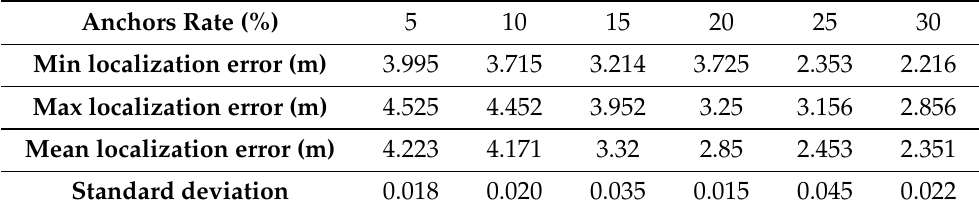
Table 1. Localization error as function of anchor rate.